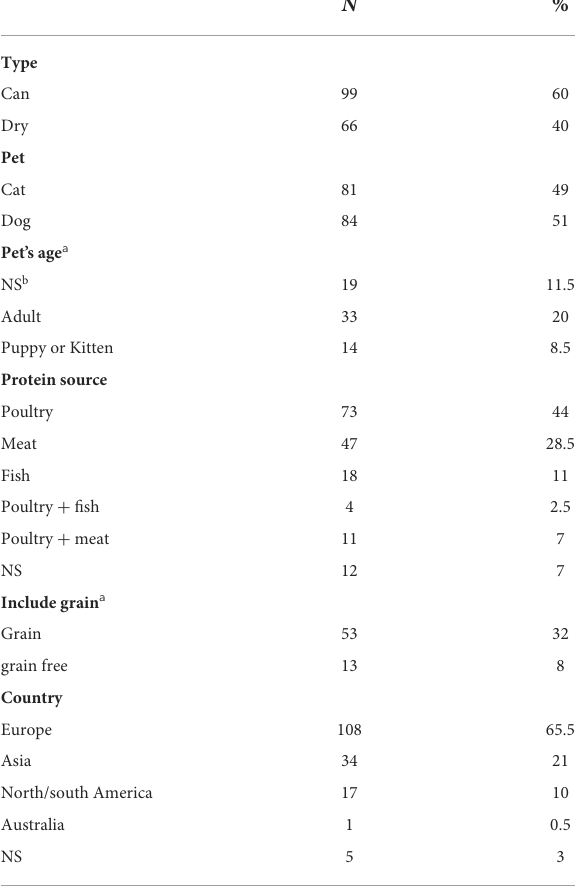
TABLE 1 Characteristics of commercially canned and dry pet food products ( n =